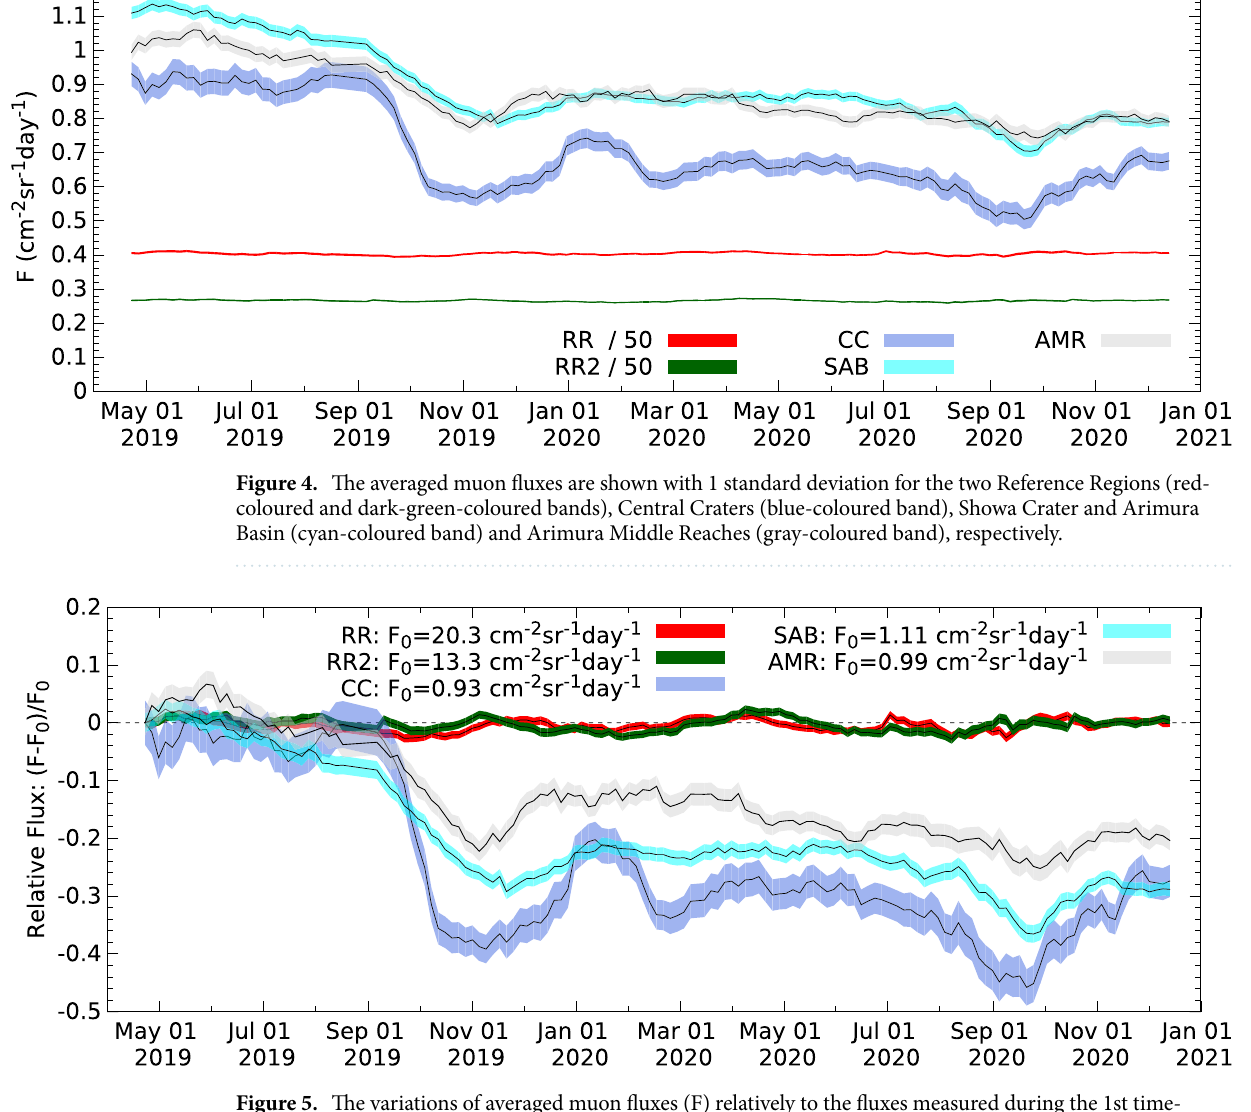
Figure 5. The variations of averaged muon fluxes (F) relatively to the fluxes measured during the 1st time- interval from 12th March to 21st April, 2019 (F 0 ). The relative flux changes are shown with 1 standard deviation bands during the data collection period for the two Reference Regions (red-coloured and dark-green-coloured bands), Central Craters (blue-coloured band), Showa Crater and Arimura Basin (cyan-coloured band) and Arimura Middle Reaches (gray-coloured band),